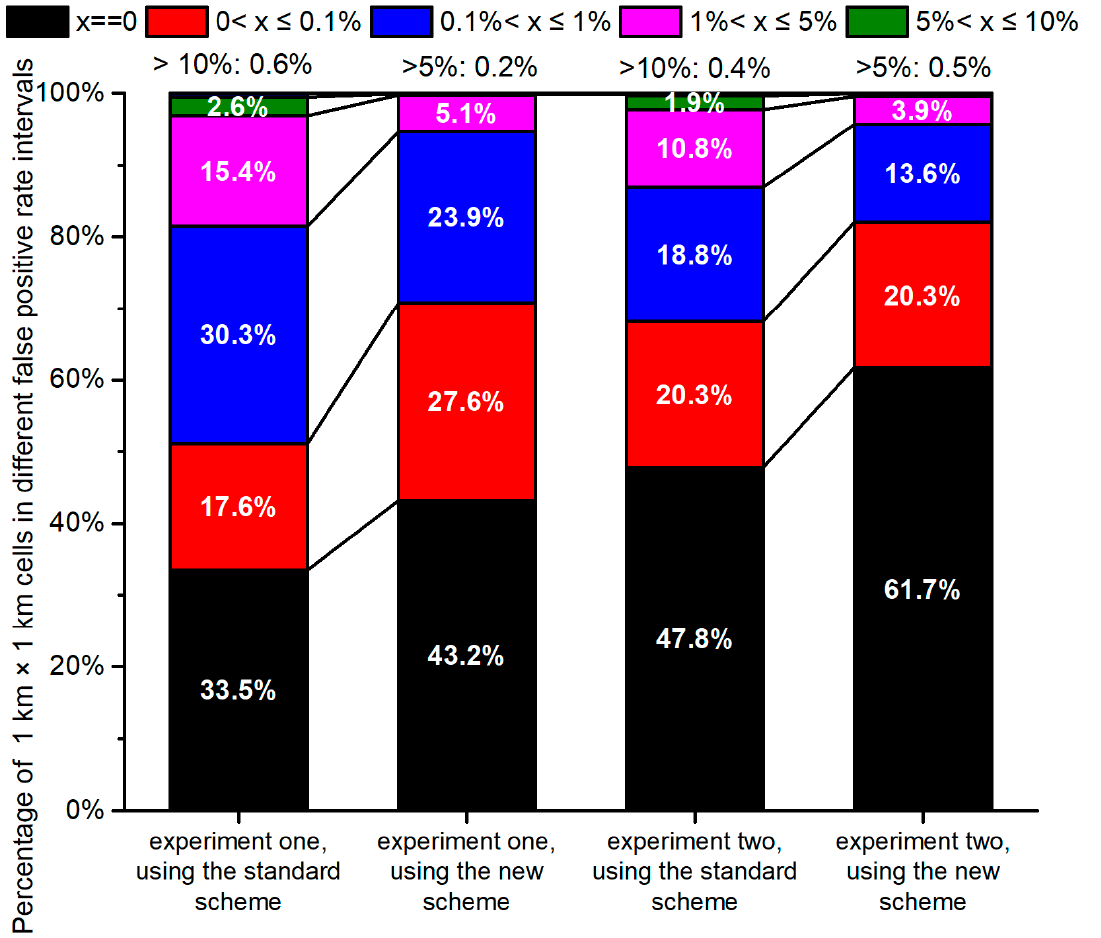
Figure 8. Percentage of 1 × 1 km cells that fall into different false positive rate intervals defined by breaks 0.1%, 1%, 5%, 10%, 20%,30%, and 40%. The false positive rate of each 1 × 1 km cell is denoted as x in the figure. Percentage of cells with zero false positive rate is displayed in black, and the percentages out of visibility (i.e., the large false positive rate that only accounts for small percentages) are summarized by labels on the top of each bar.